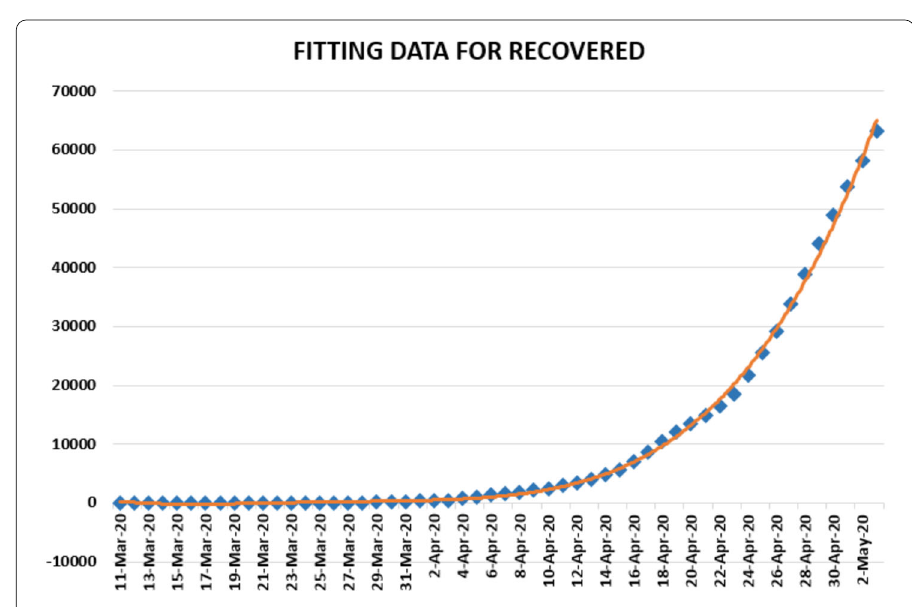
Figure 14 Polynomial fitting for recovered people in Turkey from 11 March 2020 to 3 May